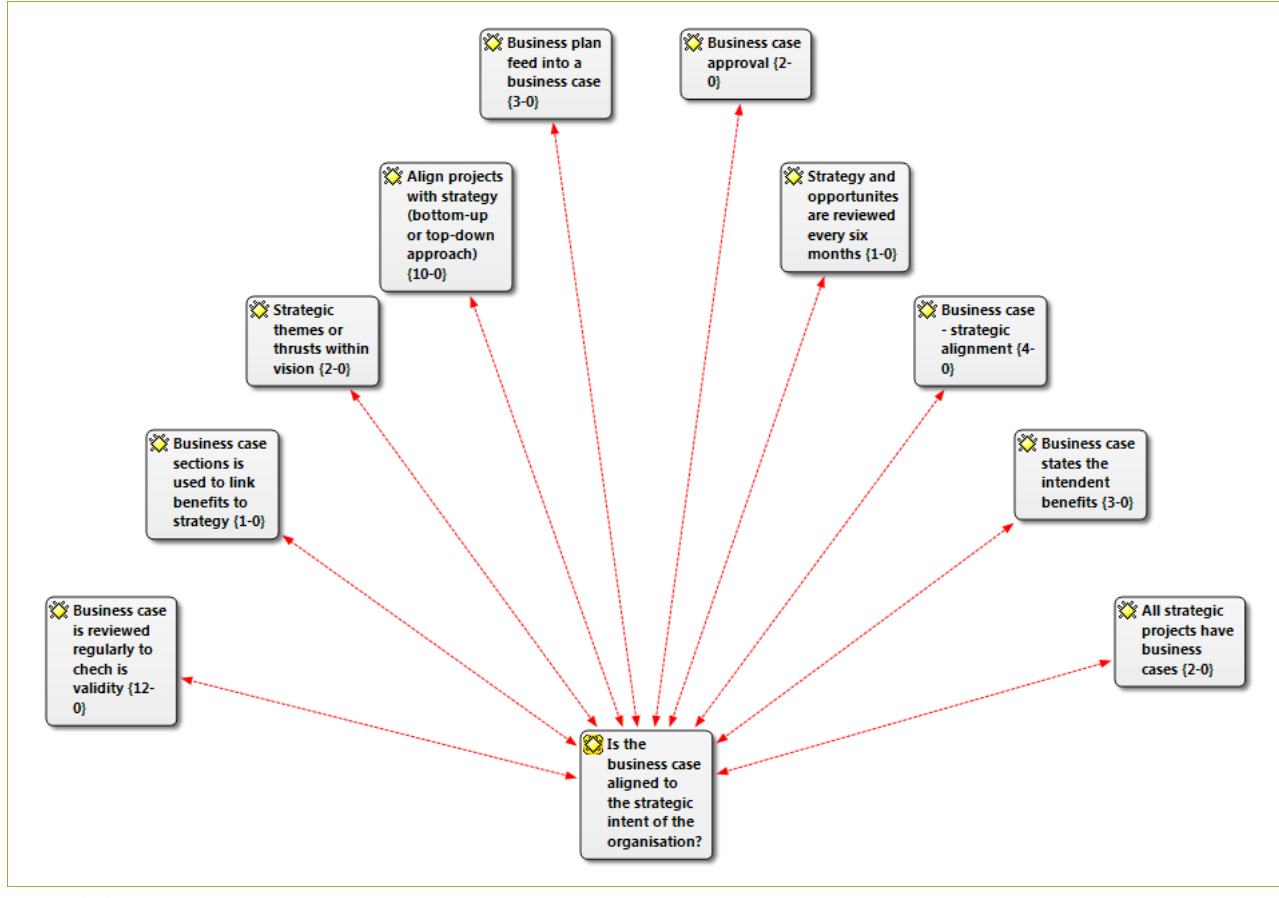
FIGURE 4: Network view: Inductive codes reflecting research question